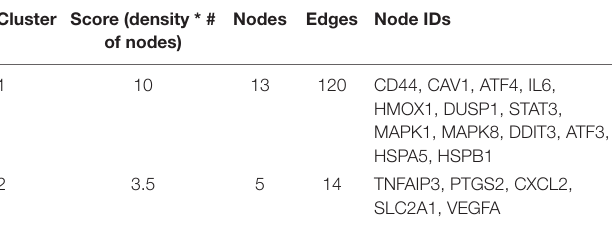
TABLE 4 | Molecular complex detection was used to process the data downloaded from the STRING to further mining gene clusters. Cluster Score (density * # of nodes)